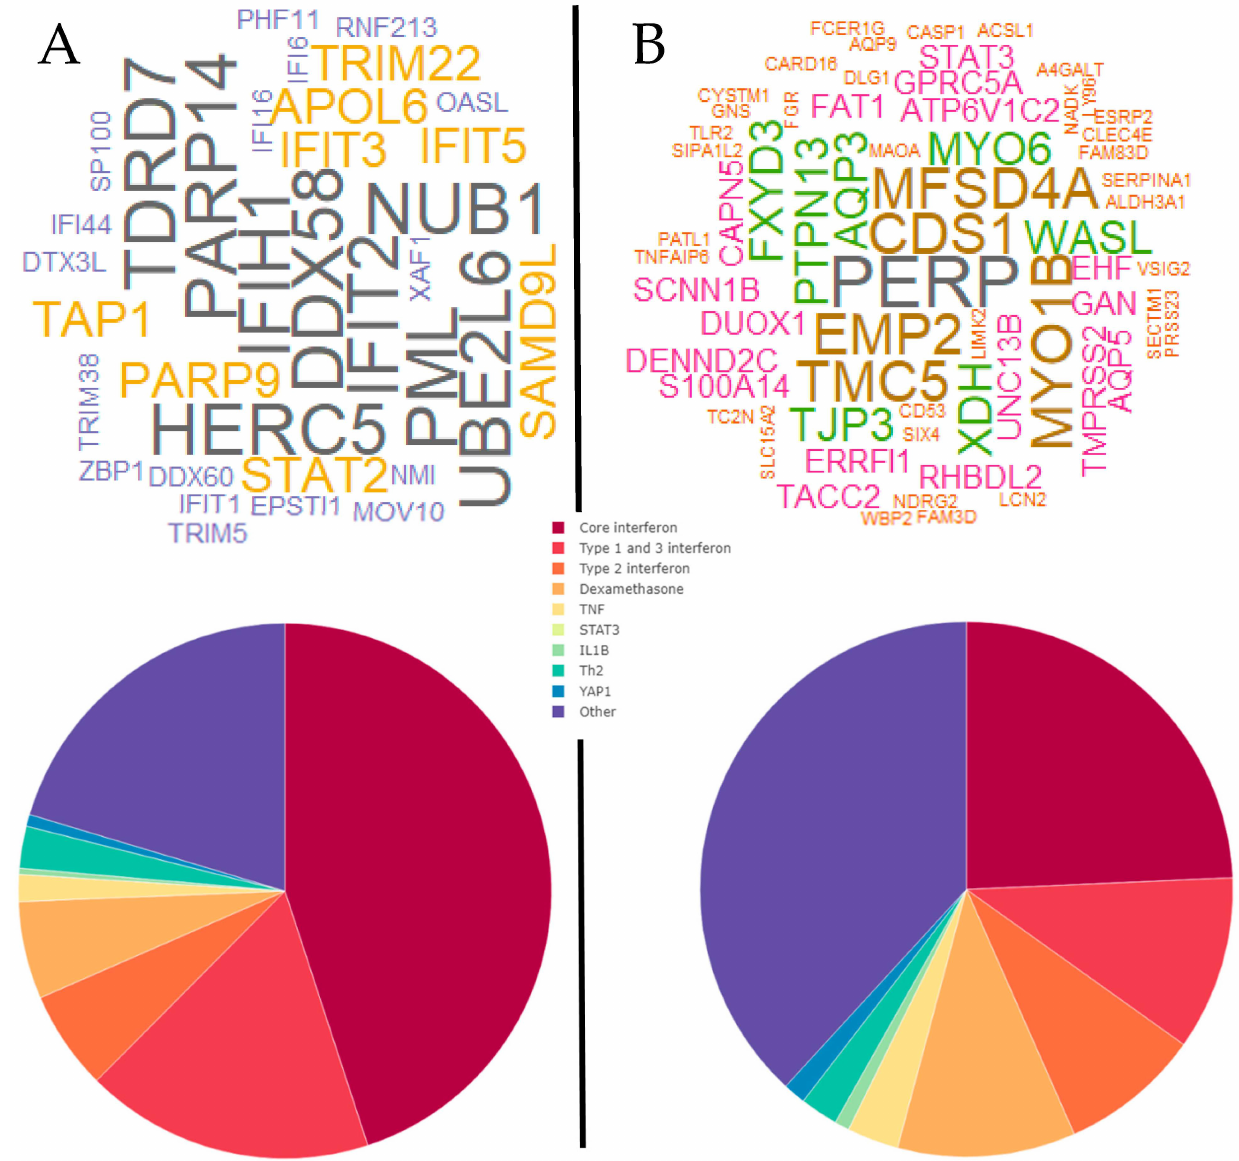
Figure 9. Word cloud plots of the top 20 hub genes for each individual at the baseline visit ( top ) and averaged network pathway proportions ( bottom ) for clusters A and B. Word color and size indicates